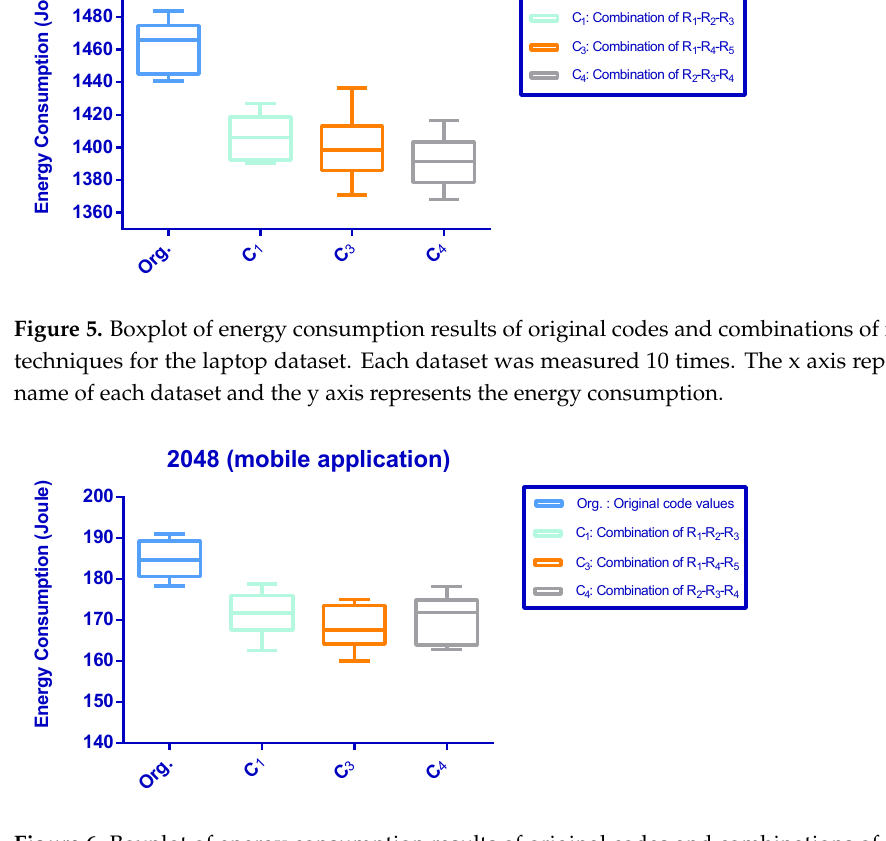
Figure 6. Boxplot of energy consumption results of original codes and combinations of refactoring techniques for the mobile phone dataset. The x axis represents the name of each dataset and the y axis represents the energy